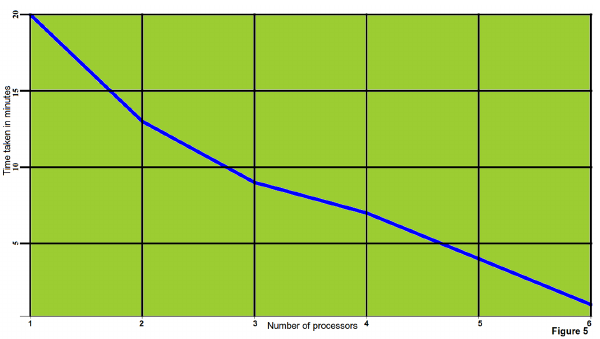
Figure 7. Impact of concurrency. The plot clearly shows that with concurrency the rate of execution could be enhanced several